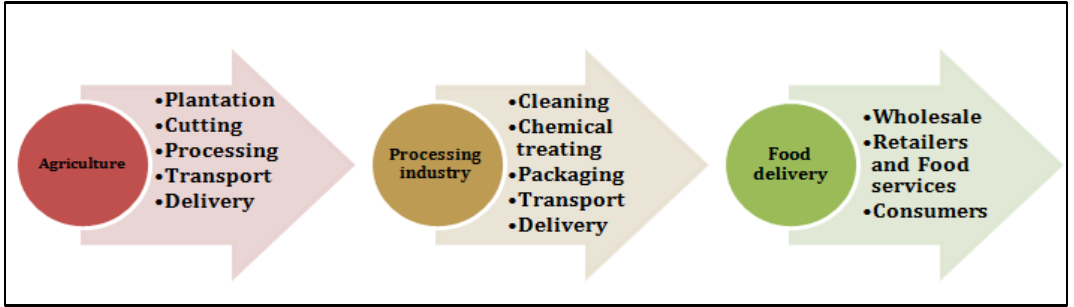
Figure 1. Processes involved in the perishable food supply chain after Bosona and Gebresenbet [15].